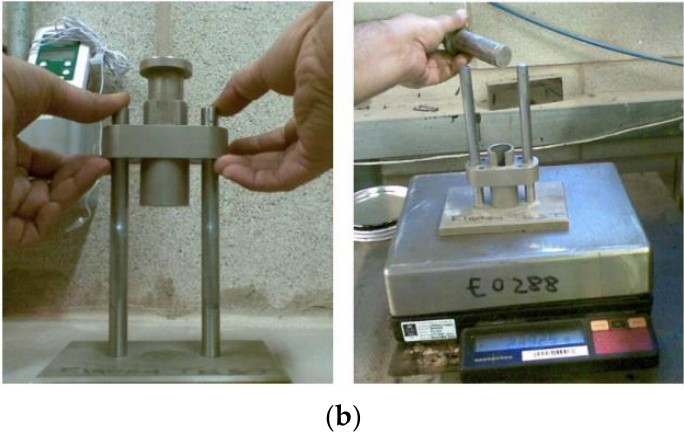
Table 2. Physical properties of fillers . Figure 1. Measurement of ( a ) particle density; ( b ) Rigden voids. Table 1. Bulk mass properties of bitumen .